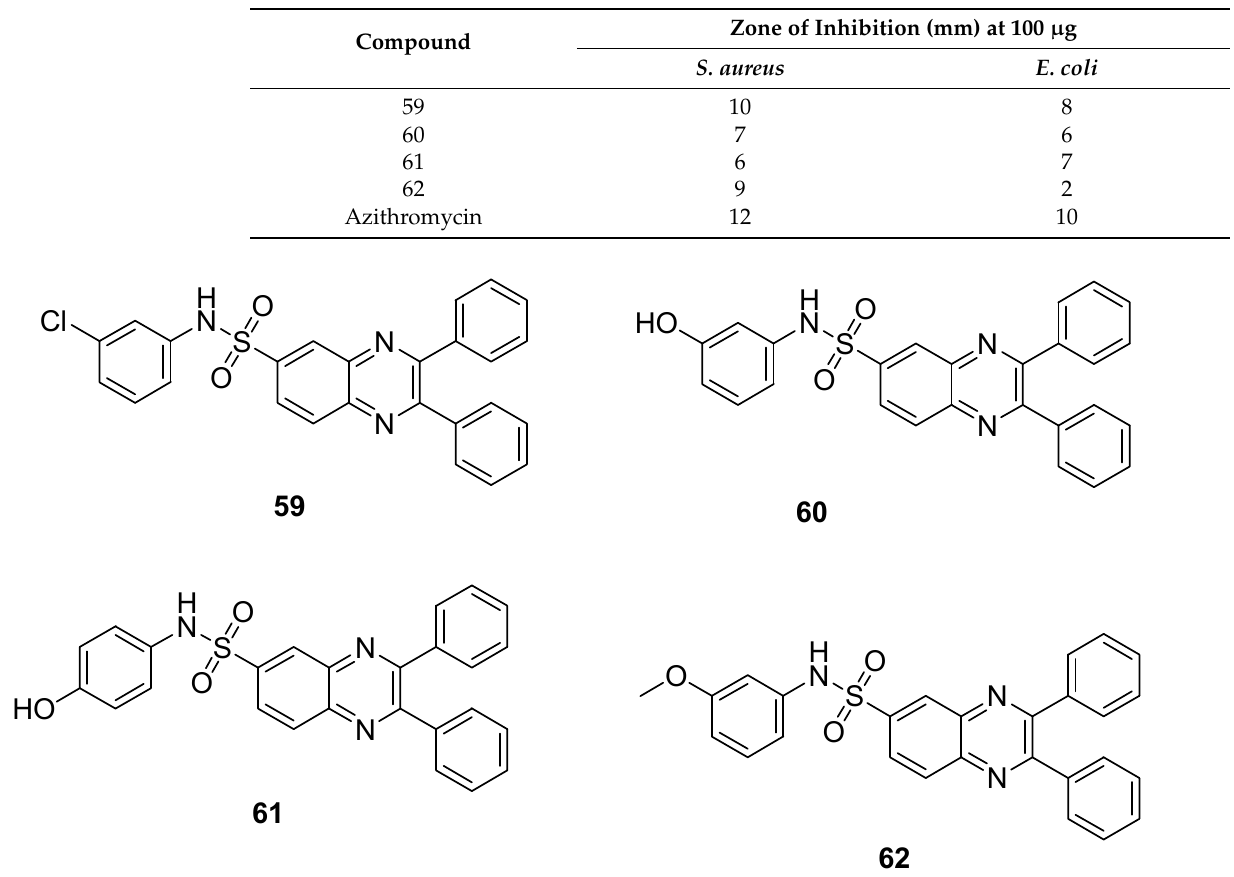
Figure 9. Substituted quinoxaline sulfonamide derivatives 59–62 . Table 3. Antibacterial activity of quinoxaline-based substituted benzene sulfonamide derivatives.